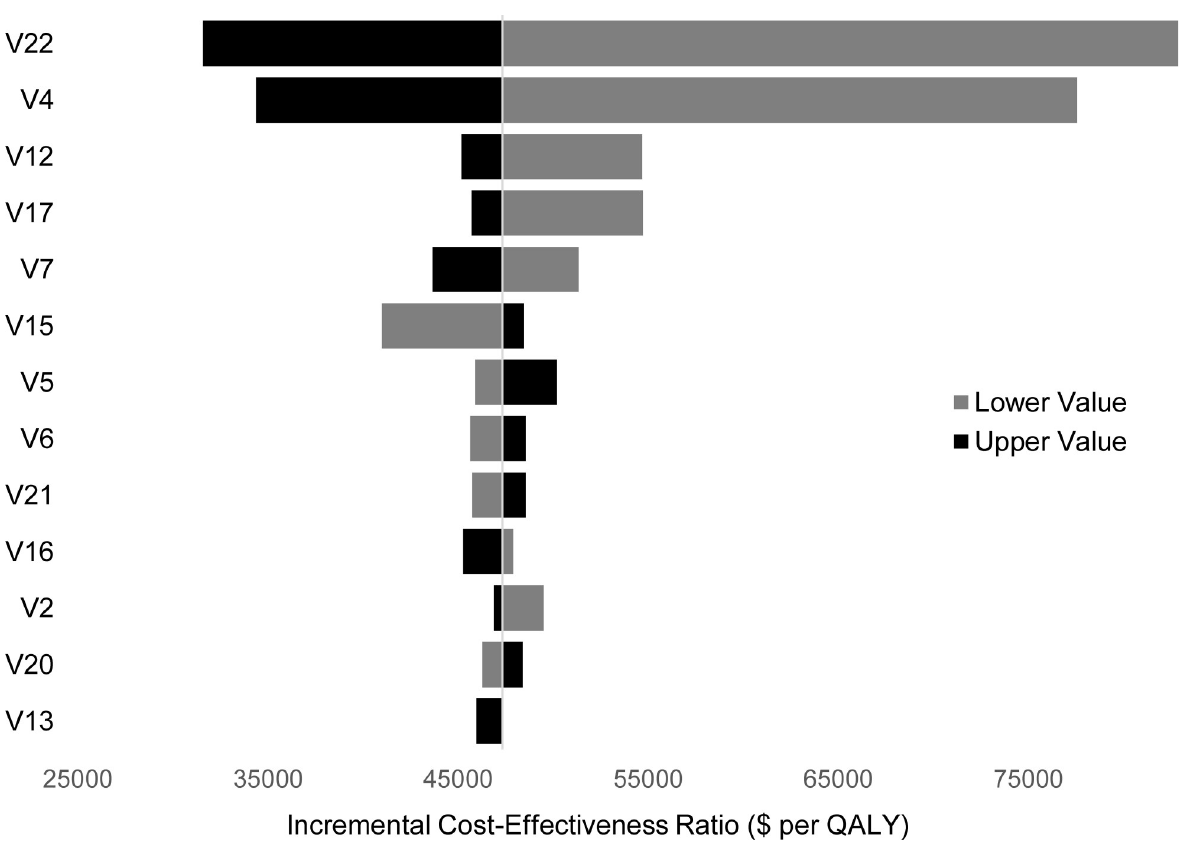
Fig 3. Tornado diagram for base case probabilistic sensitivity analysis. Note: All currency represented in 2018 United States dollars. Abbreviations: V–Variable Number (as defined in Table 1); QALY–quality-adjusted life-years.